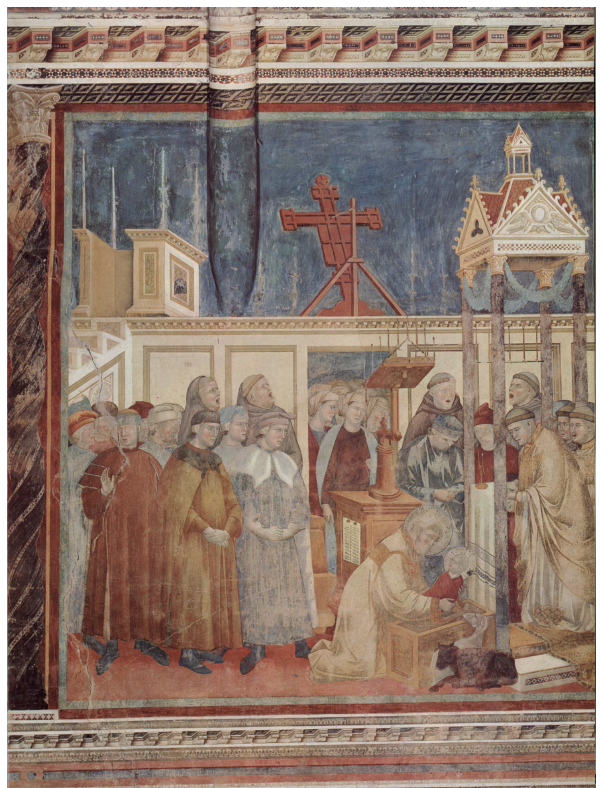
Figure 13. Nativity scene by Giotto (ca. 1297–1300). St. Francis Upper Church, Assisi, Italy. Note the change in locus from the out- door manger to an urban, interior, populated, public church. Source: public domain – Wiki